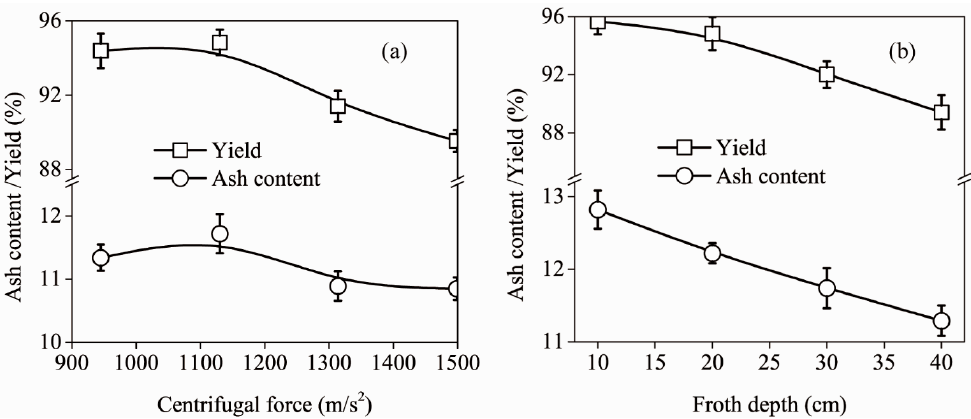
Figure 6. Effects of centrifugal acceleration ( a ) 20 cm froth depth and froth depth ( b ) 1130 m/s 2 centrifugal force on rougher flotation performance of the flotation column.